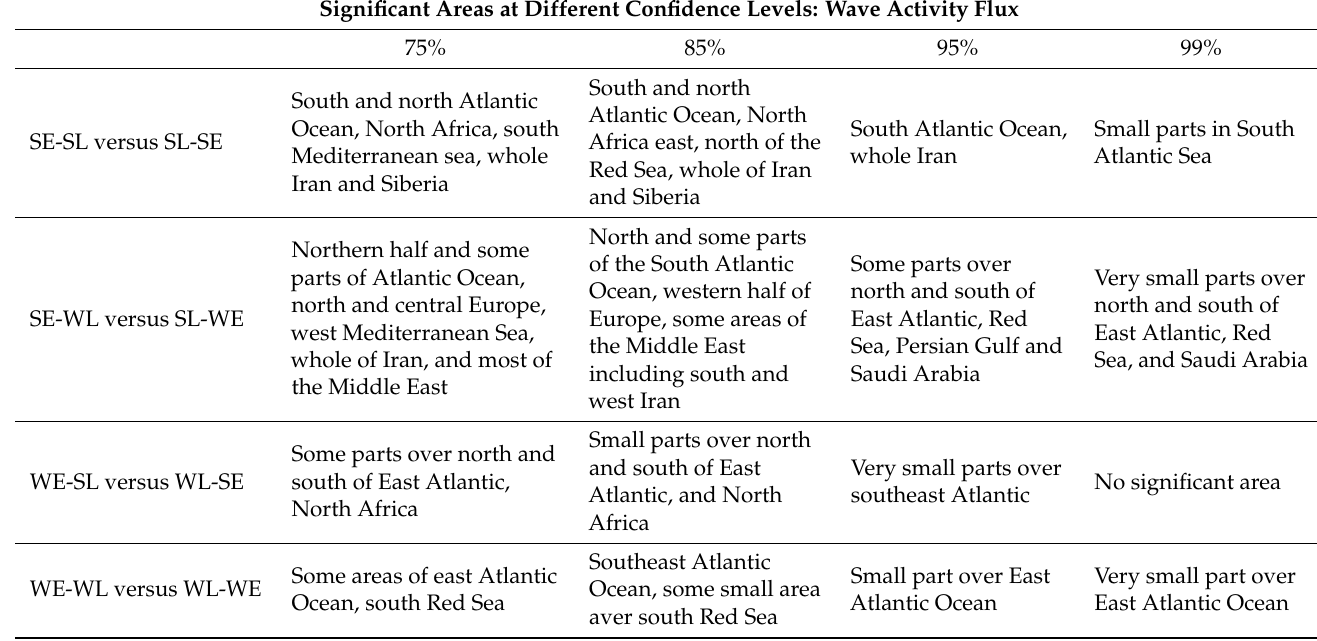
Table 4. Areas of statistically significant differences at different confidence